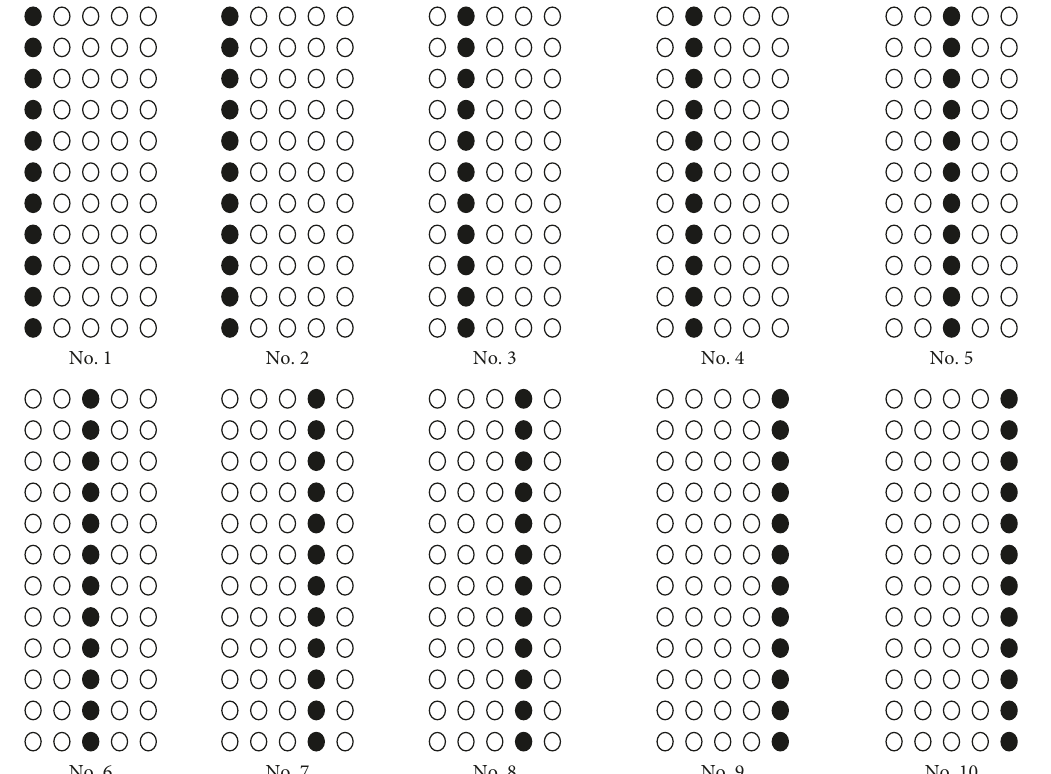
Figure 4: Simulation results of discrete DHNN model.